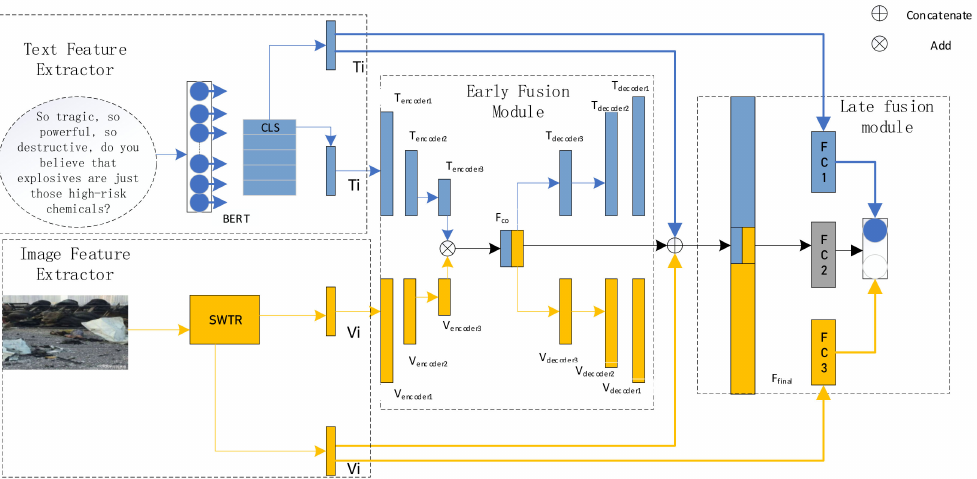
Figure 1. Our false information detection